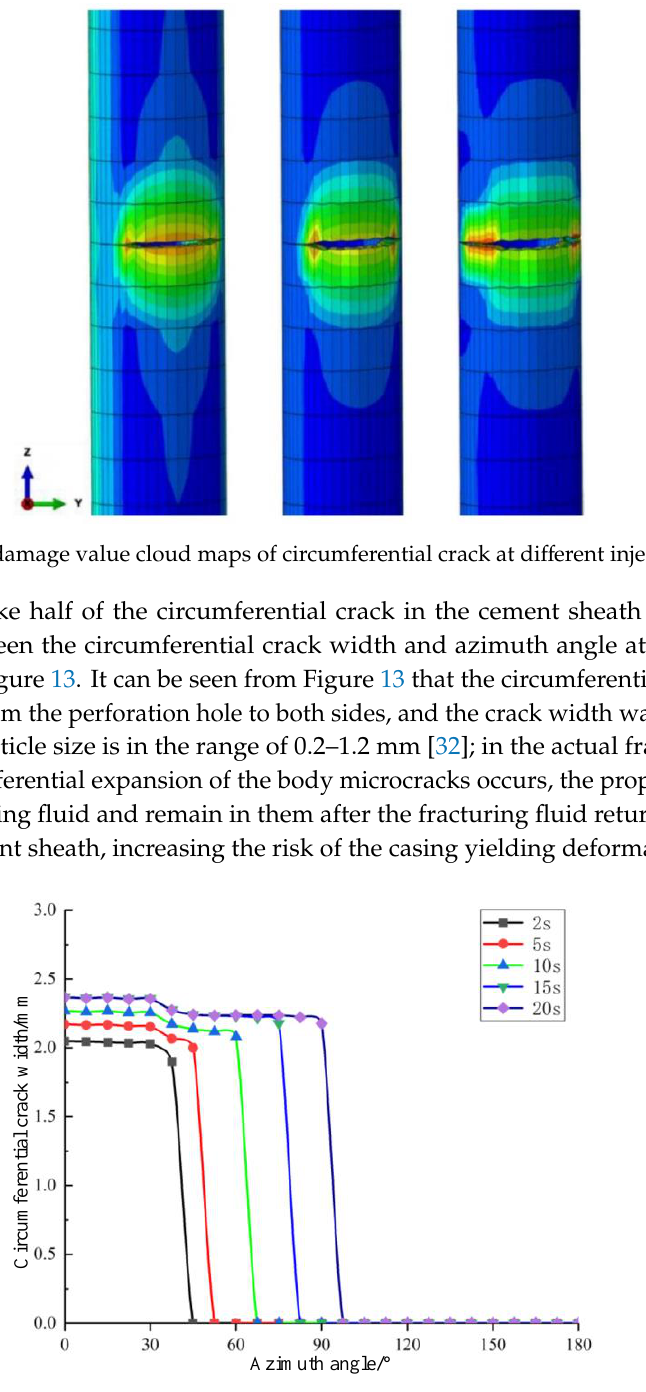
Figure 11. The relationship between crack length and injection time under different injection rates.